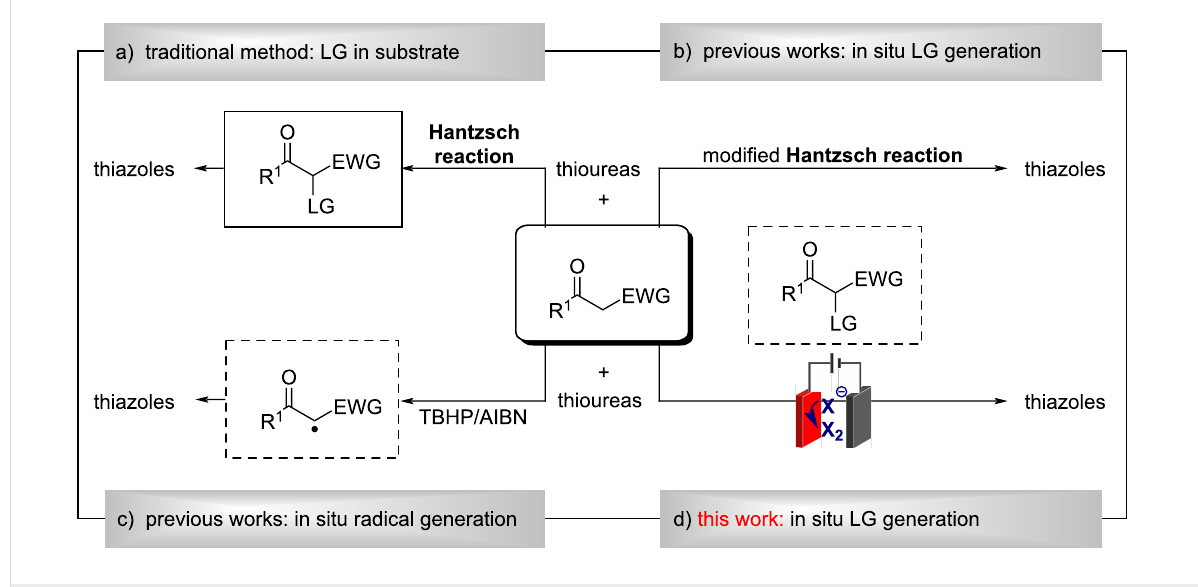
Scheme 1: Methods for the synthesis of thiazoles using active methylene ketones as starting